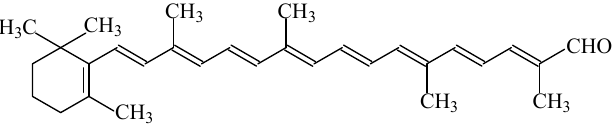
Figure 9. Structural formula of β -apo-8 ′ -carotenal (E160e). β -apo-8-carotene consists of dark-purple crystals with a metallic luster or a crystalline powder, and can be isolated from spinach, oranges, grass, tangerines or calendula. The diluted or stabilized forms of E160e are solutions or suspensions of β -apo-8 (cid:48) -carotenal water and contain different proportions of cis/trans isomers.